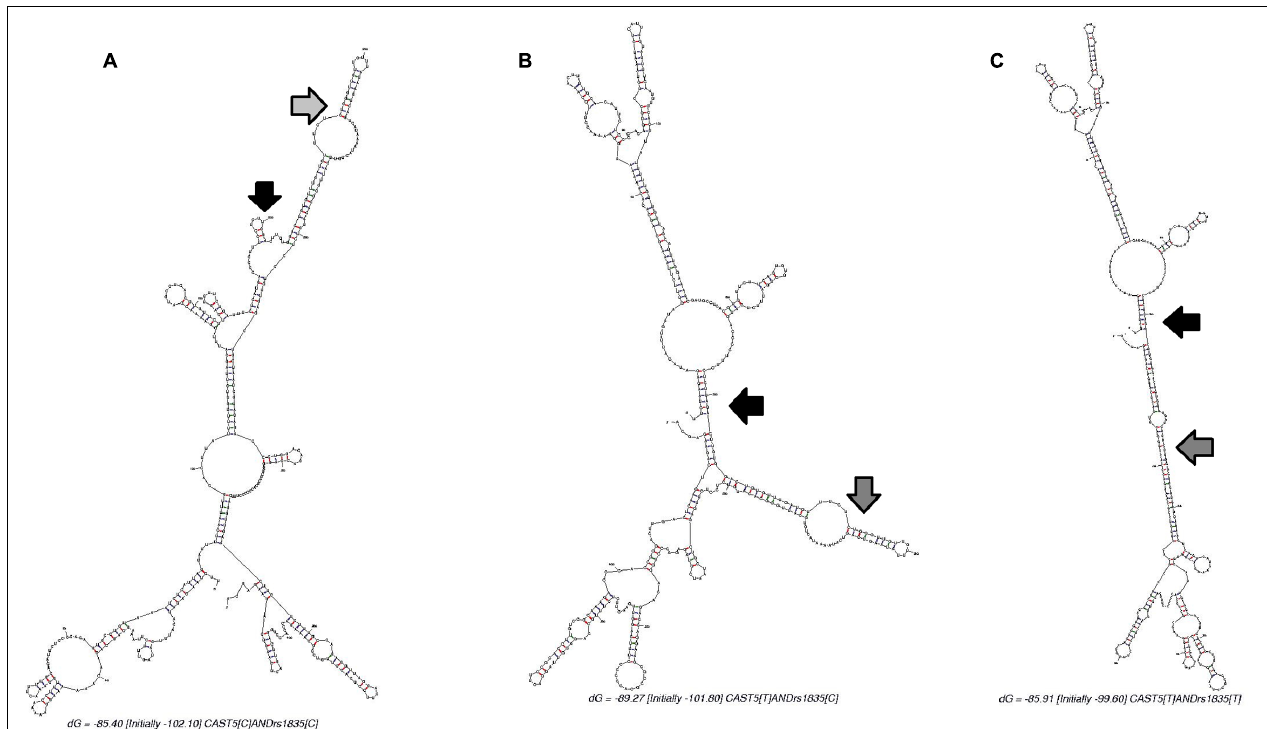
FIGURE 3 | Predicted mRNA structure of a 429 bp segment of the calpastatin gene harboring the Cast5 and rs210861835 polymorphisms (200 bp upstream of Cast5 and 200 bp downstream of rs210861835). The black and gray arrows indicate the location of Cast5 and rs210861835, respectively. (A) . Folding for Cast5-C/rs210861835-C ( (cid:49) G = − 85.40 kcal/mol) or Cast5-C/rs210861835-T ( (cid:49) G = − 83.20 kcal/mol). (B) . Folding for Cast5-T/rs210861835-C ( (cid:49) G = − 89.27 kcal/mol). (C) . Folding for Cast5-T/rs210861835-T ( (cid:49) G = − 85.91